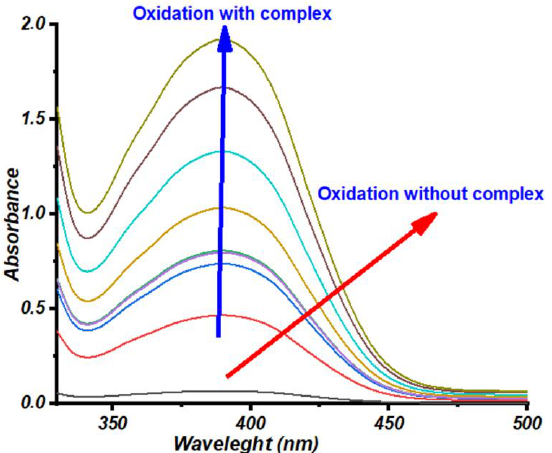
Figure 2. Absorbance spectrum of o -quinone as a function of time for the combination 2 L 2 /Cu(NO 3 ) 2.